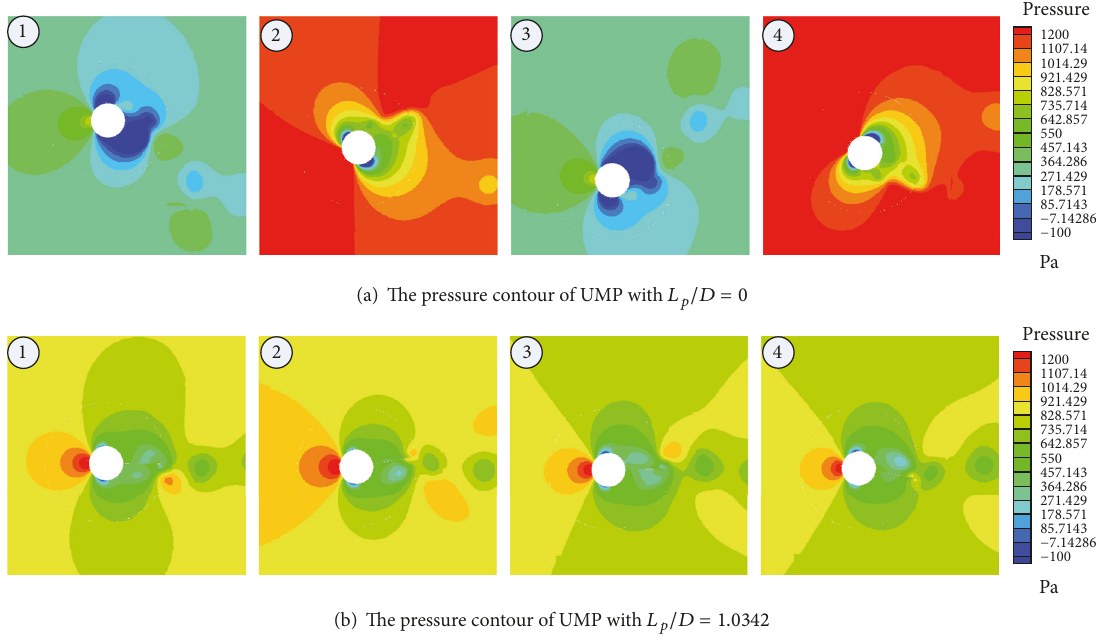
Figure 26: Pressure cloud of the bare UMP and UMP with